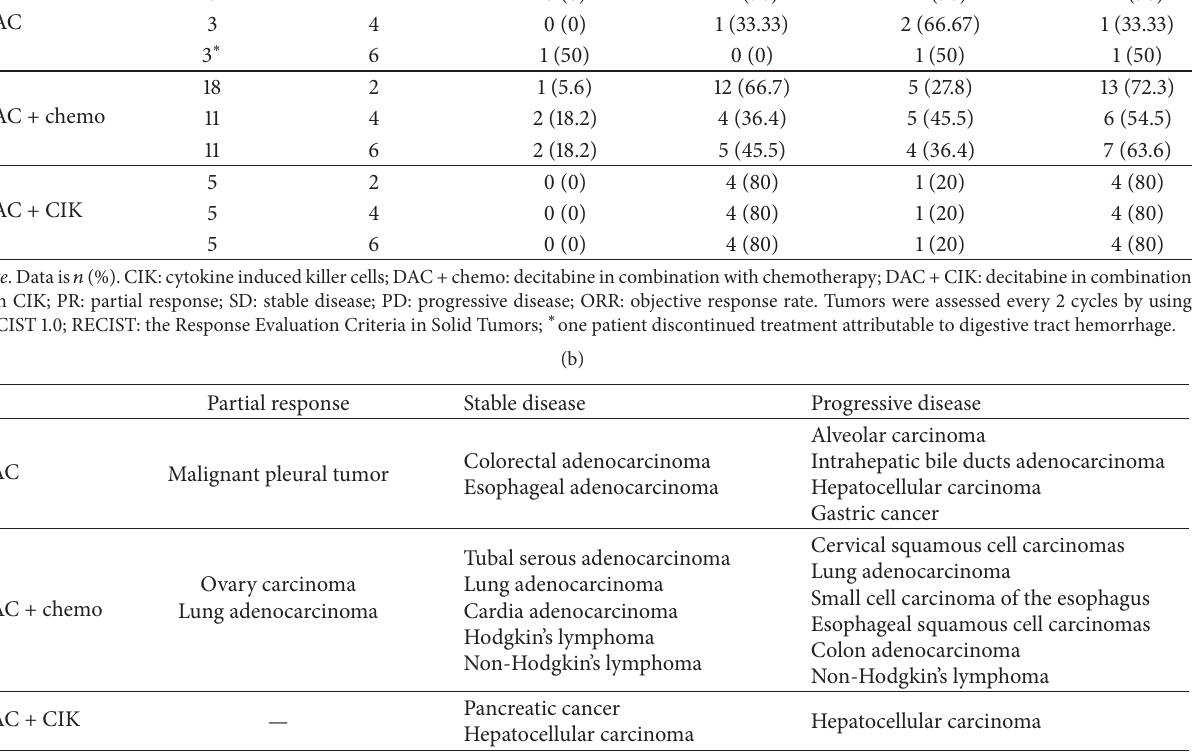
Table 5: Baseline diagnosis of patients whose PFS was significantly prolonged compared to their previous PFS. 𝑛